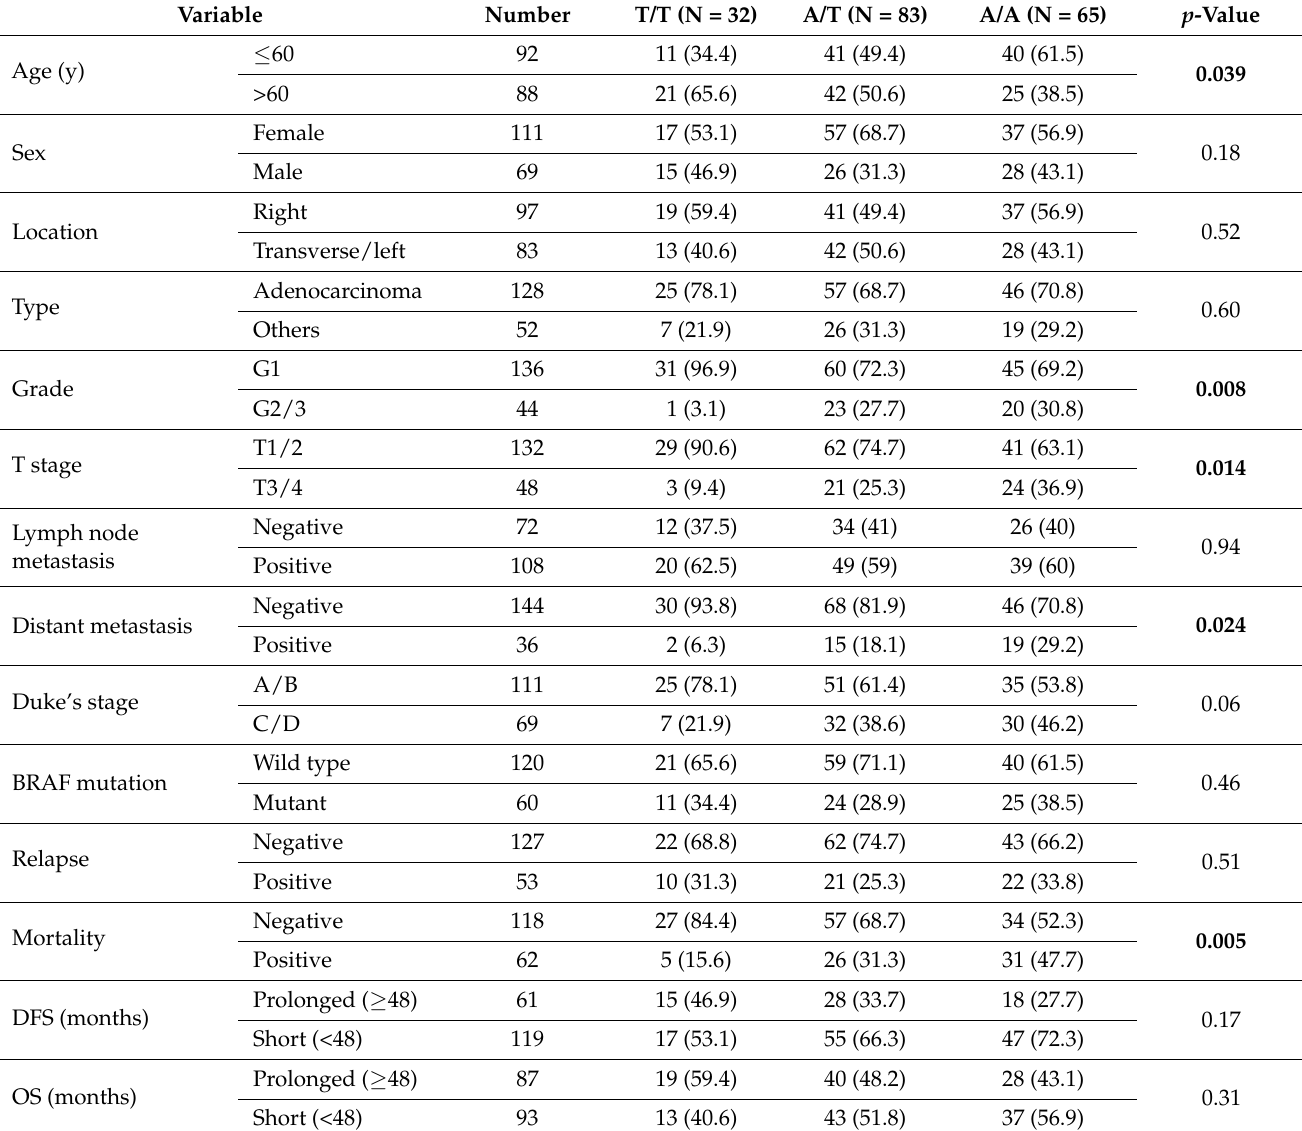
Table 2. Association of LINC-ROR rs1942347 genotypes with clinical and pathological